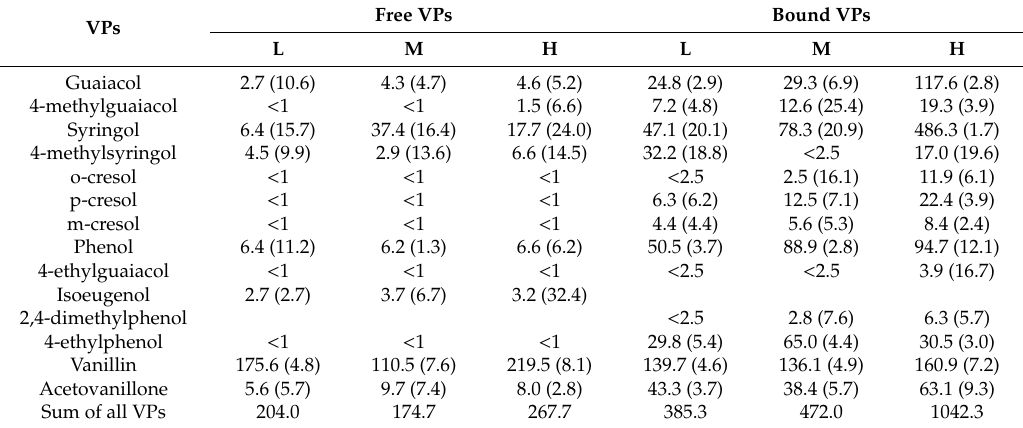
Table 5. Free and bound VP content (ng / g) and inter-replicate RSD (in brackets, n = 3) of grape berries after exposure to di ff erent levels of